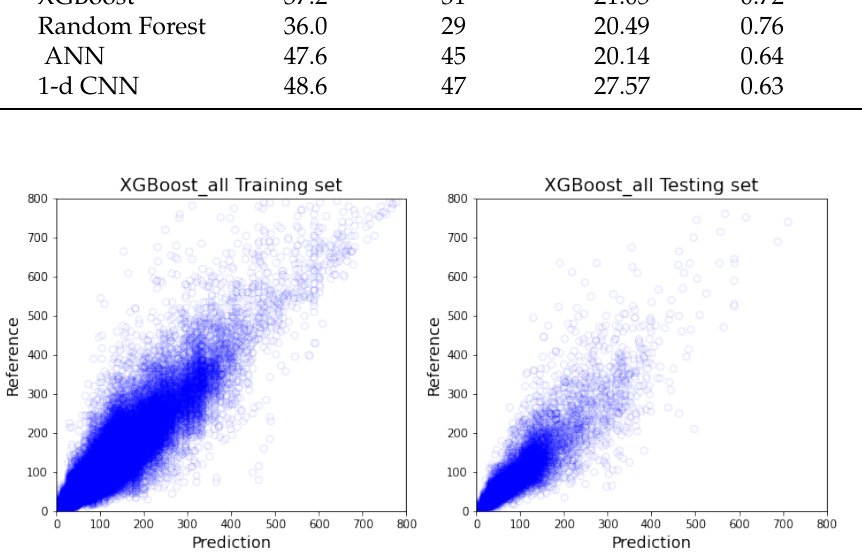
Figure 5. All-inclusive model with XGBoost (The visualization of training and testing data for all-inclusive model with